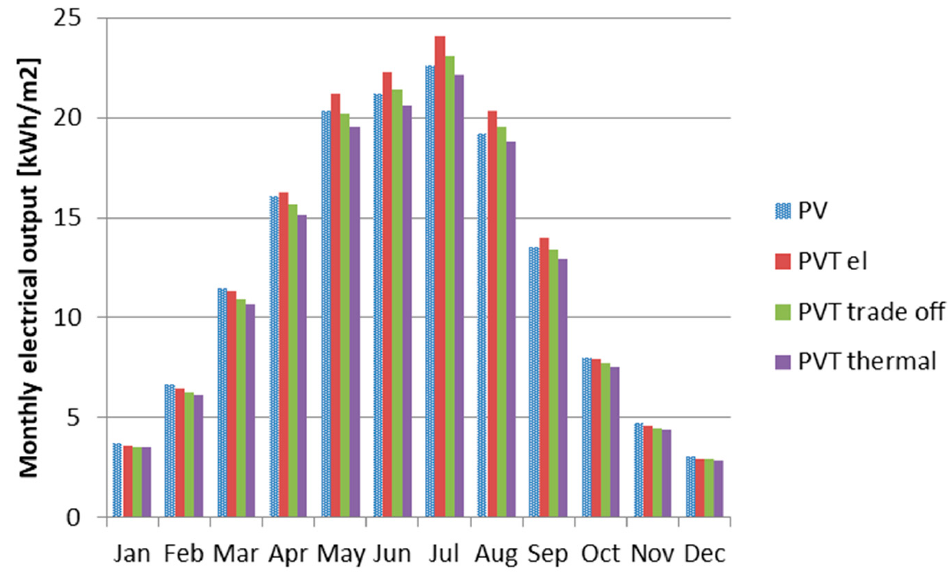
Figure 18. Monthly electrical output of the PV panel and three optimal PVT designs.